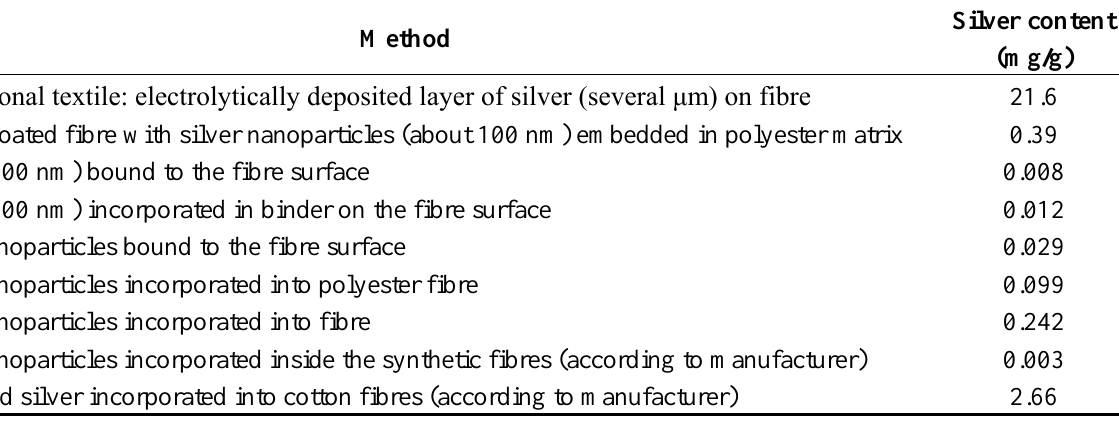
Table 2. Methods of silver incorporation into fabrics ([15],